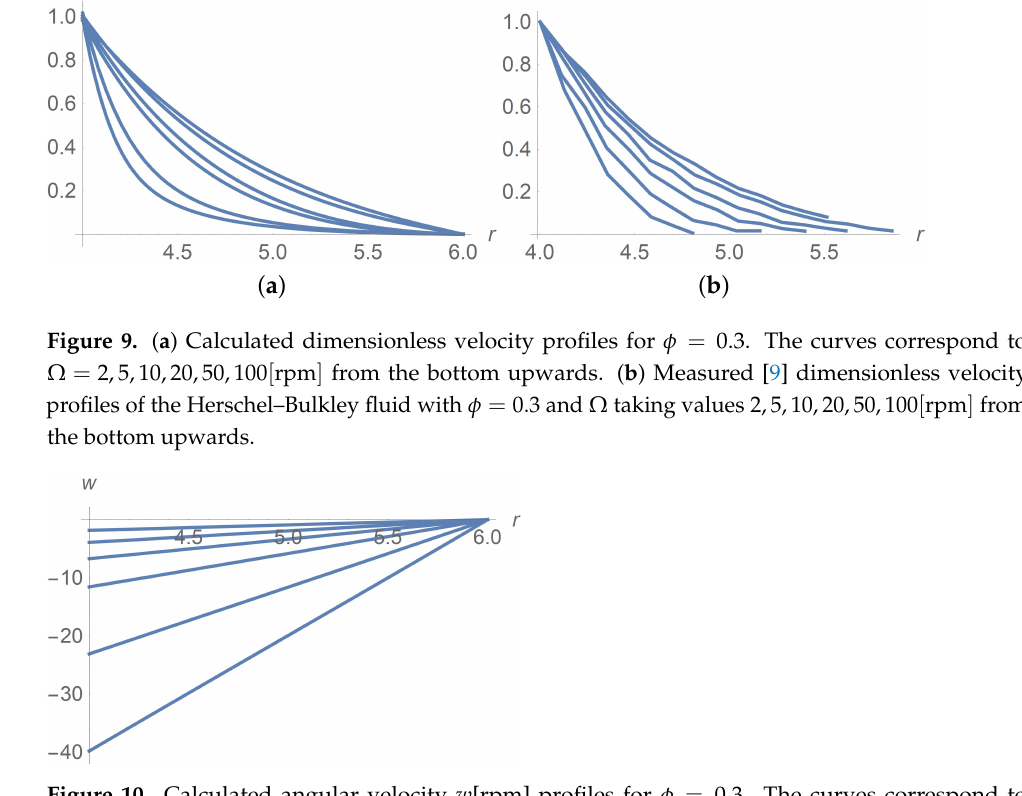
Figure 10. Calculated angular velocity w [rpm] profiles for φ = 0.3. The curves correspond to Ω = 2,5,10,20,50,100[rpm] from the top